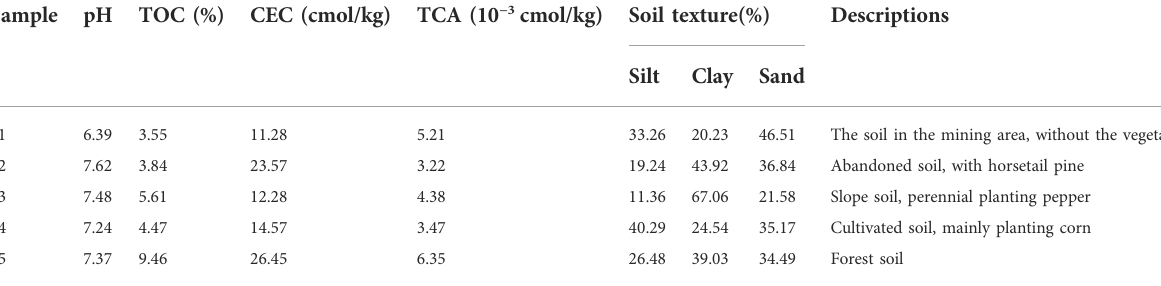
TABLE 1 Physical and chemical properties of the soil at the sampling